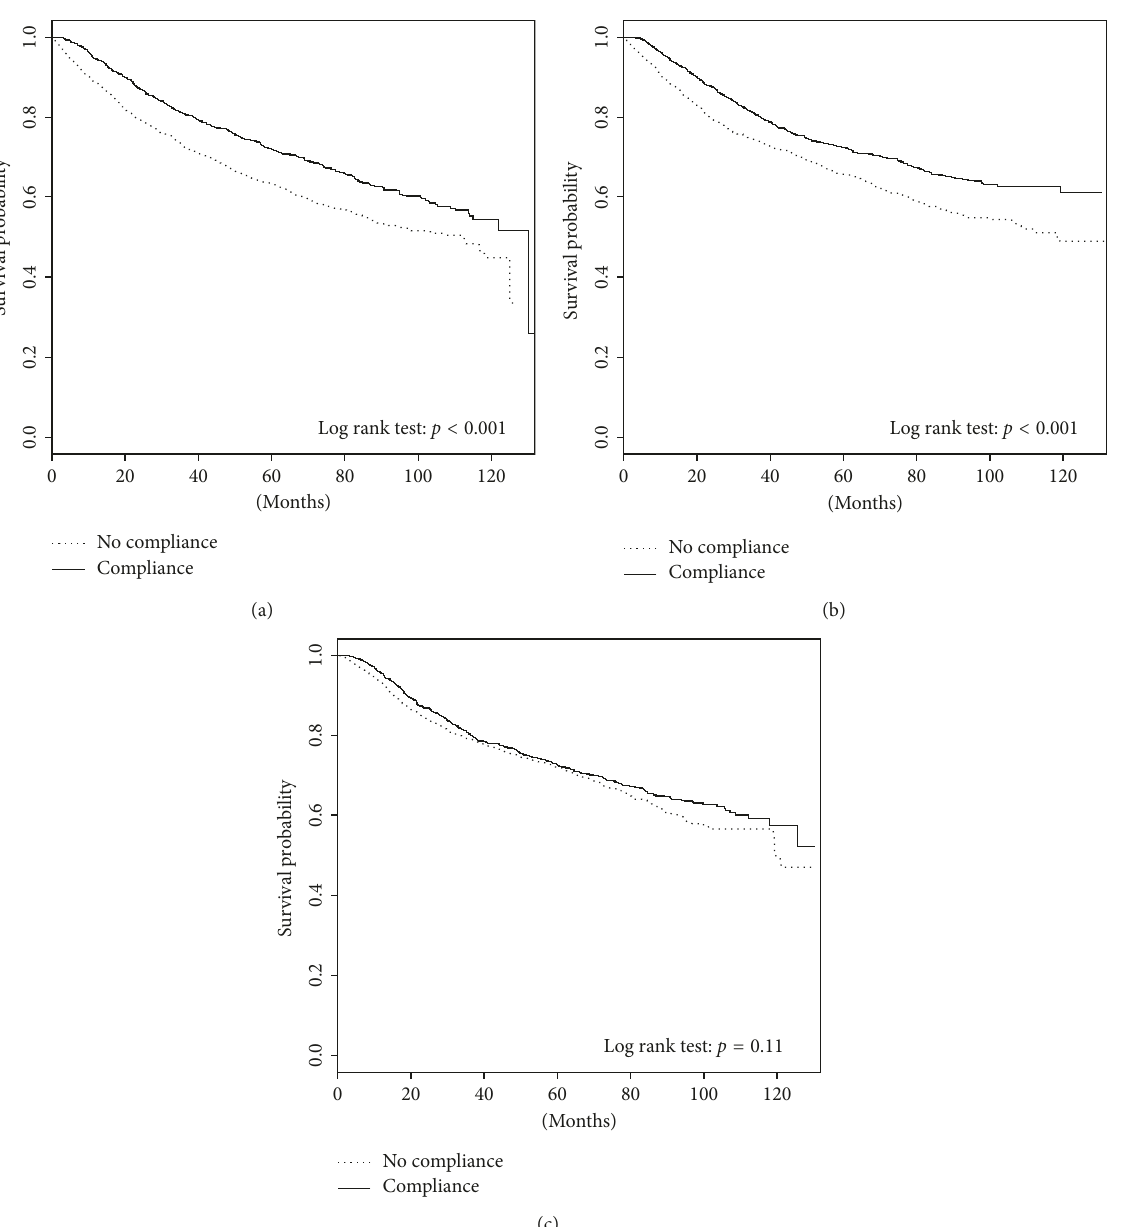
Figure 2: Kaplan–Meier plots displaying the impact of adherence to NCCN guidelines on overall survival stratified by hospital volume: (a) 1T hospitals, (b) 2T hospitals, and (c) 3T